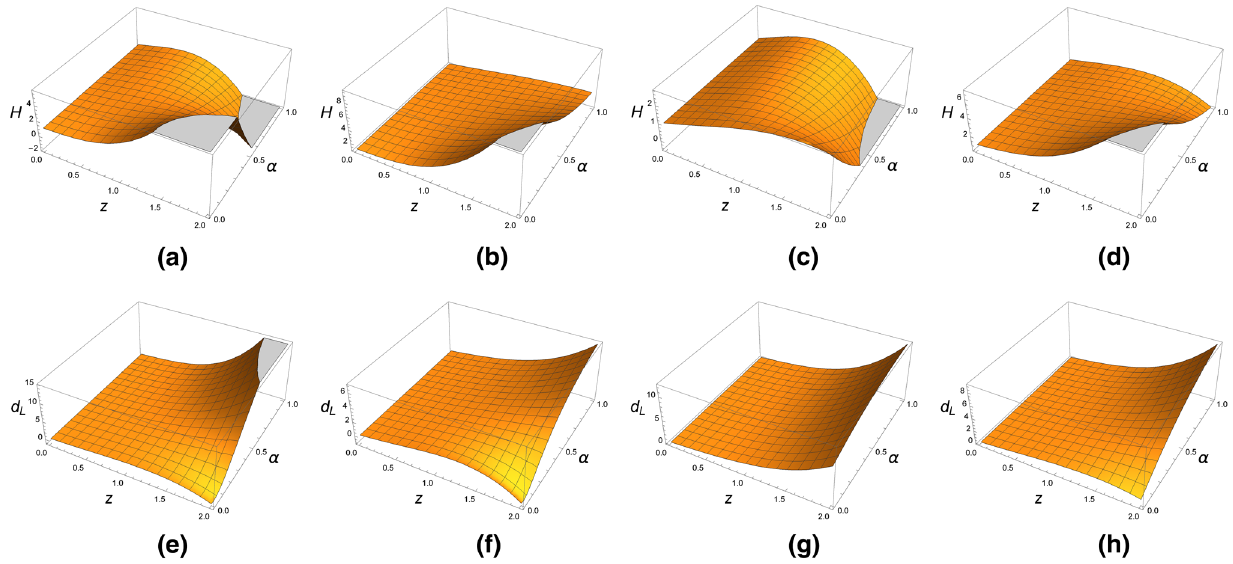
Fig. 1 The figure depicts the redshift evolution of the Hubble function and of the luminosity distance for the following fluid models: Redlich– Kwong in a and e , (modified) Berthelot in b and f , generalized Chap-